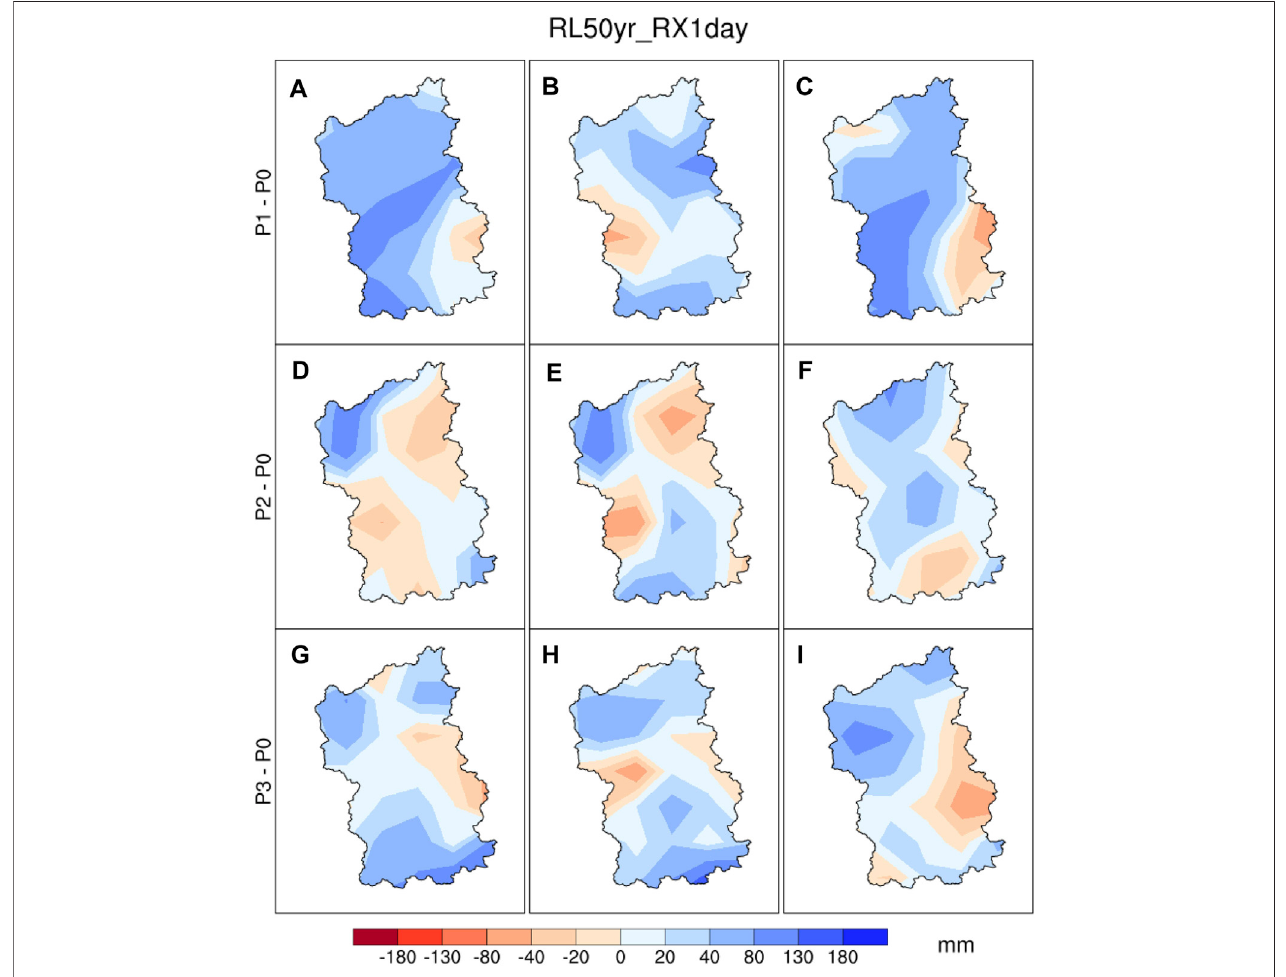
FIGURE 6 | Spatial distribution of the projected changes in 50-year return levels (mm) of RX1day under the RCP4.5 for (A) the entire rainy season, (B) the fi rst-half rainy season, and (C) the second-half rainy season during P1 (2021 – 2040) relative to present-day P0 (1986 – 2005). (D – F) and (G,H) are the same as (A – C) , but for changes during P2 (2041 – 2060) and during P3 (2081 – 2098) respectively.